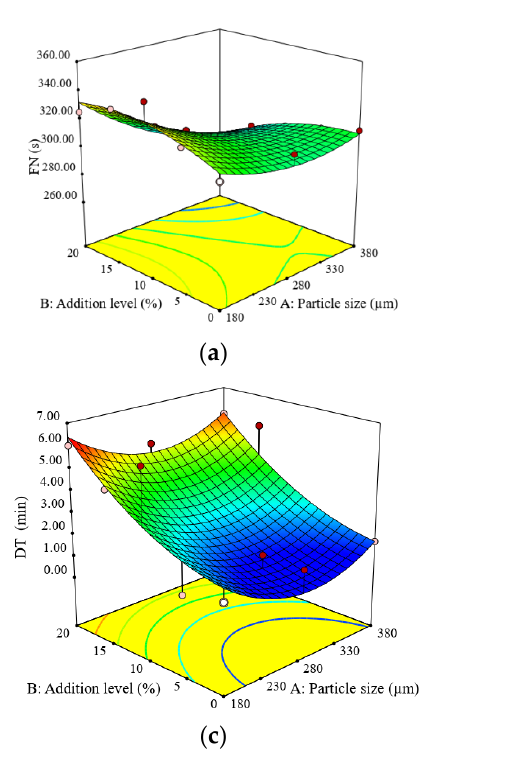
Figure 1. 3D response surface graphic presenting the effect of quinoa flour particle size and addition level on: ( a ) falling number index (FN), ( b ) water absorption (WA), ( c ) development time (DT), and ( d ) dough stability (ST).